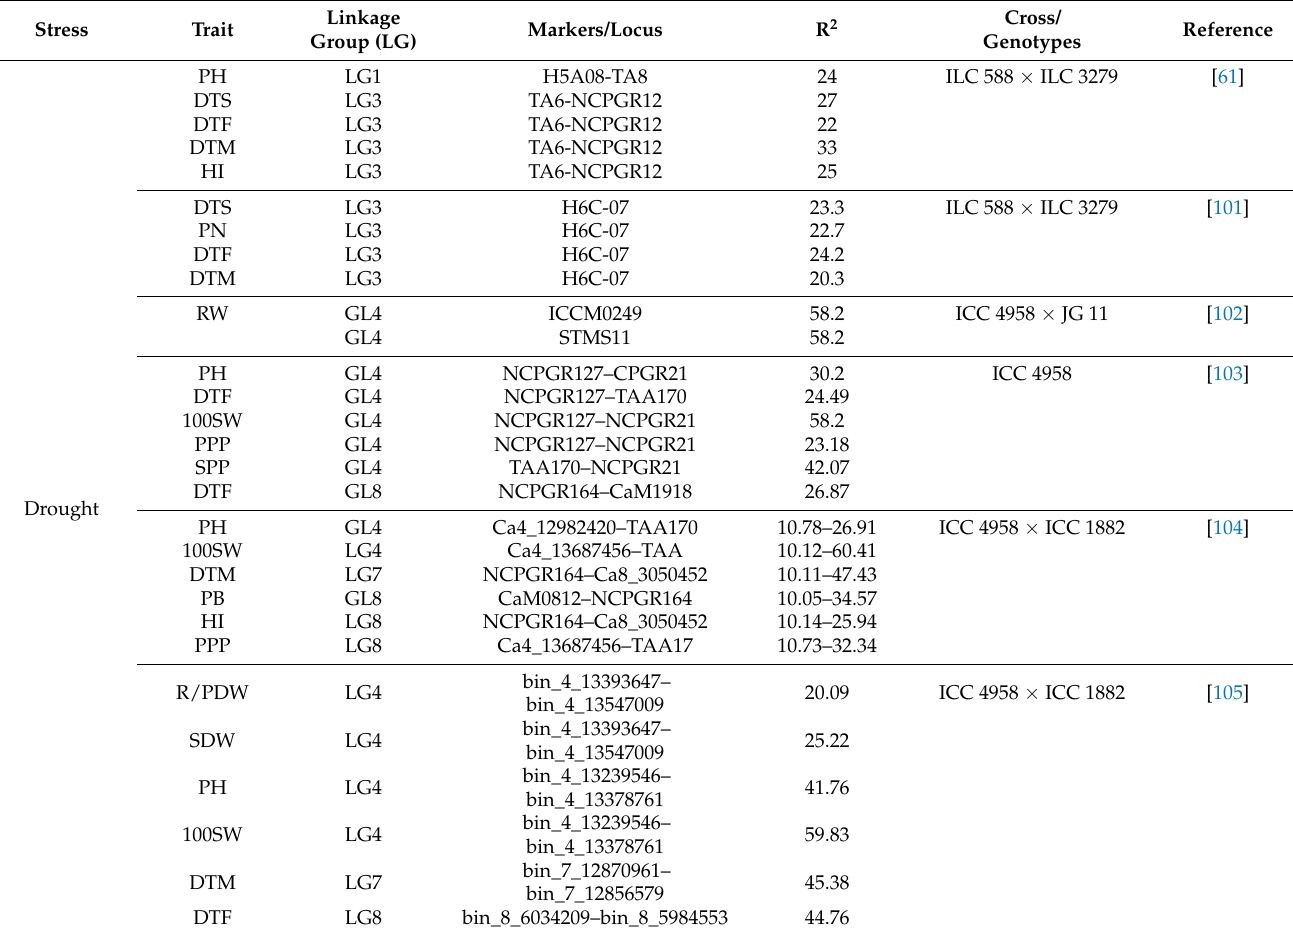
Cross/ Genotypes